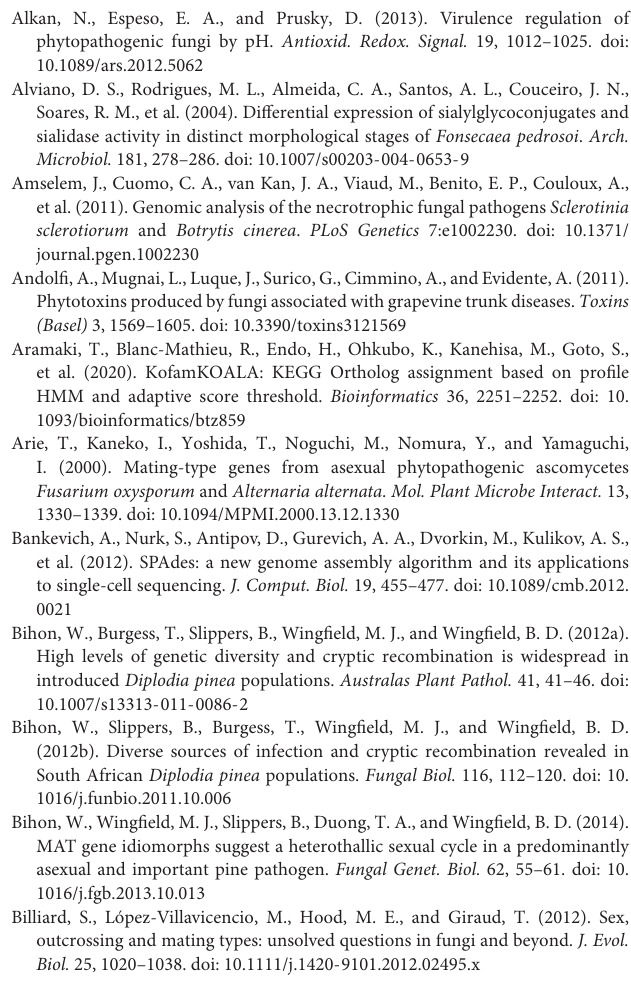
Supplementary Table 6 | Conserved protein domains of Botryosphaeriaceae fungi mating type genes. Supplementary Table 7 | Conservation of mating type genes of Botryosphaeriaceae fungi. Supplementary Table 8 | Reconstruction of ancestral mating type of Botryosphaeriaceae fungi. Supplementary Table 13 | Genes number of CZAy related to